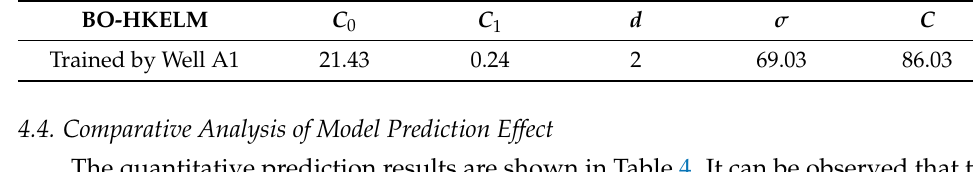
Figure 6. The fitness reduction rate in different iterations of Bayesian optimization algorithm for training HKELM. Table 3. The optimal parameters optimized by Bayesian algorithm in Well A1.